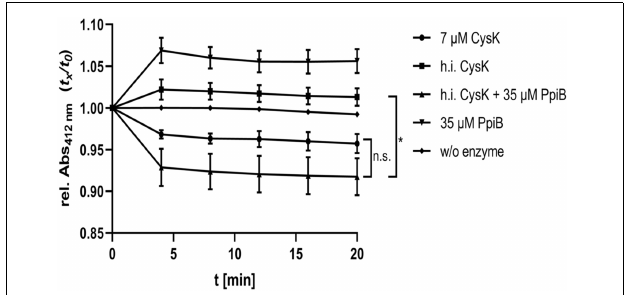
FIGURE 7 | CdPpiB restores CysK-activity after heat denaturation. O -acetyl-sulfhydrylase activity of recombinant CysK was measured by the decrease of OD 412 at 30 ◦ C. Activity of 7 µ M recombinant CysK diminished after inactivation at 56 ◦ C for 30 min, and could be restored by the addition of recombinant PpiB in 5-times molar excess. Shown are mean and SEM of three independent measurements proteins of two different productions. Statistical significance was calculated by unpaired t- Test with Welch’s correction ( ∗ p ≤ 0.05, n.s., not